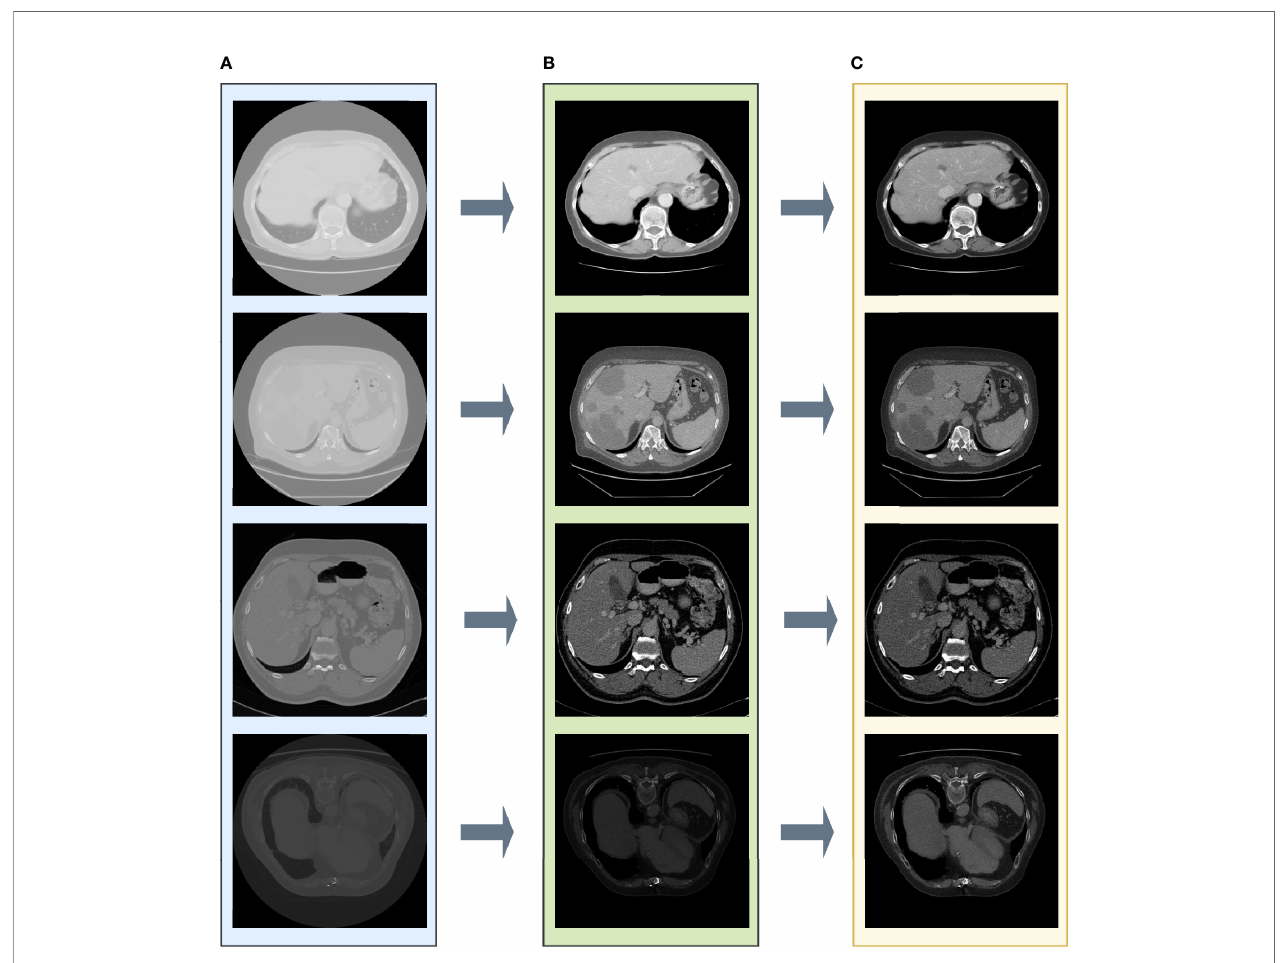
FIGURE 3 | The results after each step inliver tumorpreprocessing process. (A) The original slide; (B) the post-Houns fi eld- fi ltered slide; (C) the poststandardized